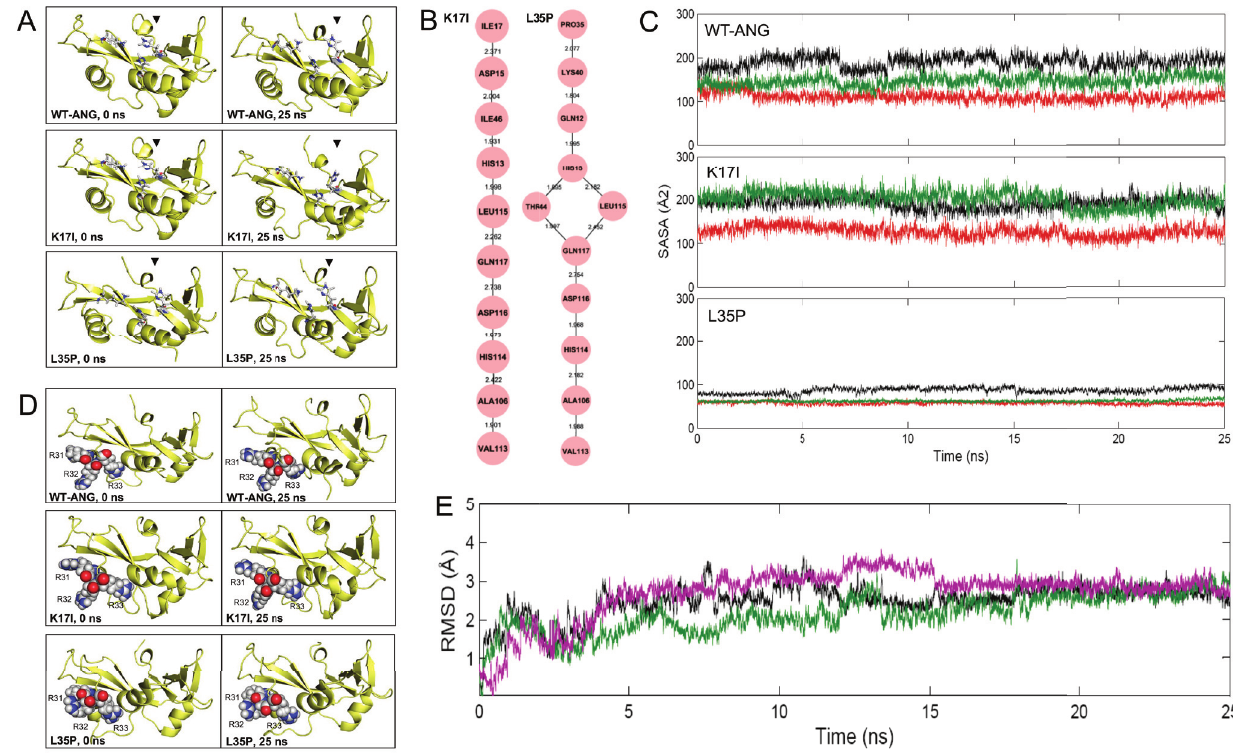
Figure 2. Output results obtained from ANGDelMut for K17I and L35P-ANG mutants. ( A ) Snapshots of ANG proteins obtained from 25 ns simulation trajectories, showing conformational switching of catalytic residue His114 in K17I- and L35P-ANG mutants compared to WT-ANG, resulting in loss of ribonucleolytic activity. ( B ) Obtained conserved hydrogen bond interaction paths from the site of mutations Ile17 and Pro35 to catalytic residue His114 from simulations for K17I and L35P mutants, where node represents the amino acid residue and edge represents the bond length between them. These paths mediated through Leu115, which induces in loss of ribonucleolytic activity. ( C ) Computed SASA values of nuclear localization signal residues 31 RRR 33 from simulations for WT-ANG and K17I and L35P-ANG mutants. SASA values are represented as R31: black, R32: green and R33: red coloured lines. SASA values for WT-ANG and K17I are higher compared to L35P-ANG mutant, suggesting loss of nuclear translocation activity of L35P mutant due to reduction of SASA value. ( D ) Snapshots of ANG proteins obtained from 25 ns simulation trajectories, showing loose packing of 31 RRR 33 nuclear localization signal residues in WT-ANG and the K17I-ANG mutant suggesting no loss of nuclear translocation activity while in L35P, the 31 RRR 33 residues are in closely packed resulting in reduction in SASA values causing loss of nuclear translocation activity. ( E ) Plot showing the stability of WT-ANG and K17I-, L35P-ANG mutants during the simulations. The RMSD of the backbone atoms from the equilibrated conformation (0 ns) is presented as a function of time. The RMSD time profiles for WT-ANG, K17I and L35P are shown in black, magenta and green coloured lines